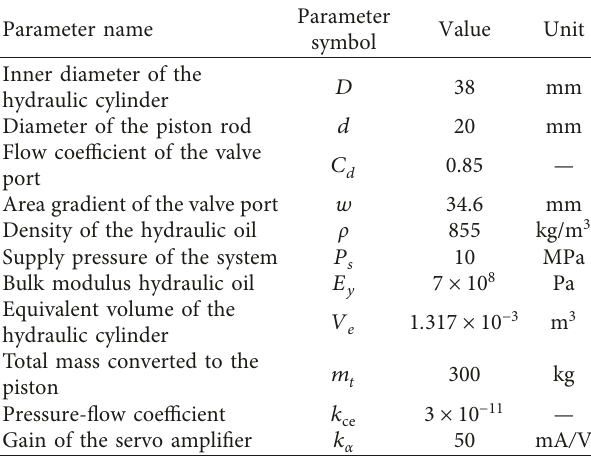
Table 3: Parameters of the electrohydraulic servo